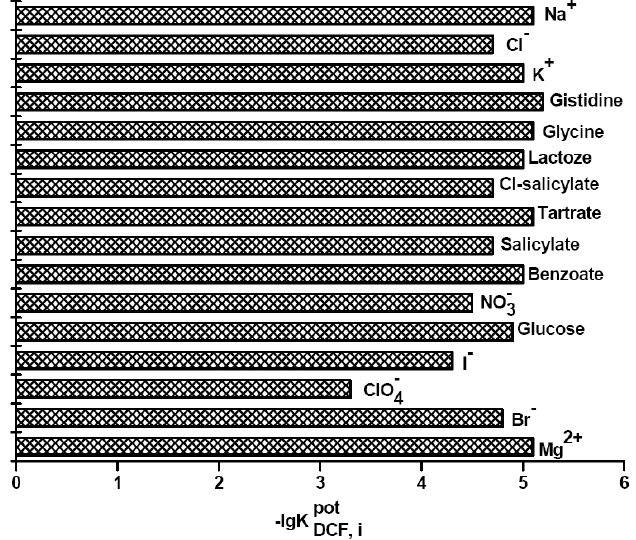
Fig. 6 Potentiometric selectivity coefficients of the diclofenac ion-selective electrode (membrane 1; pH